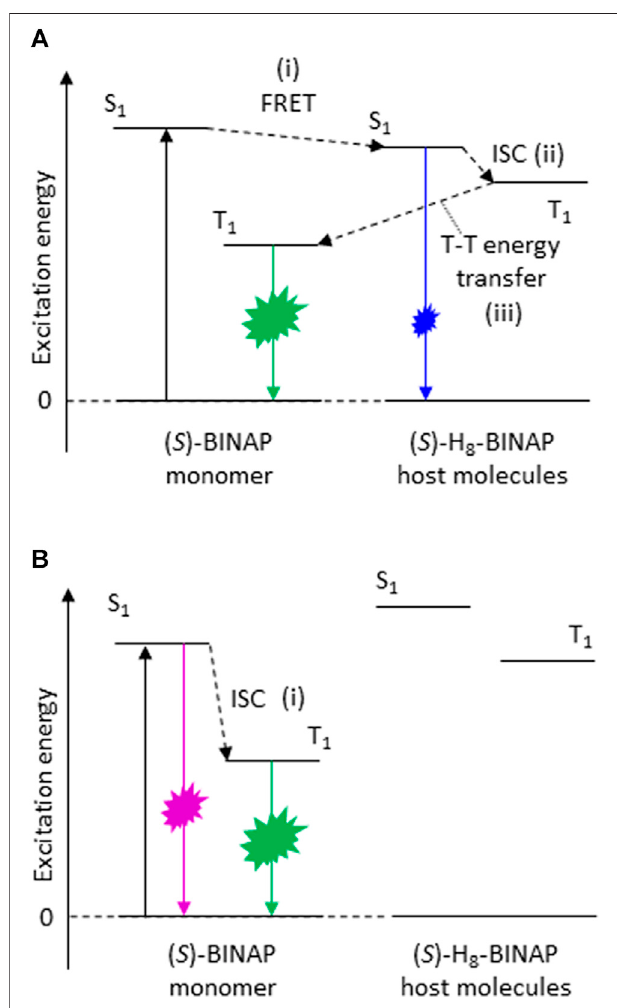
FIGURE 4 | Scheme showing T 1 generation in ( S )-BINAP. (A) In ( S )-H 8 - BINAP hosts. (B) In amorphous β -estradiol host. (( S )-BINAP (cid:1) ( S )-( − )-2,2 ′ - bis(diphenylphosphino)-1,1 ′ -binaphthyl ( S )-H 8 -BINAP (cid:1) ( S )- bis(diphenylphosphino)-5,5 ′ ,6,6 ′ ,7,7 ′ ,8,8 ′ -octahydro-1,1 ′ -binaphthyl).